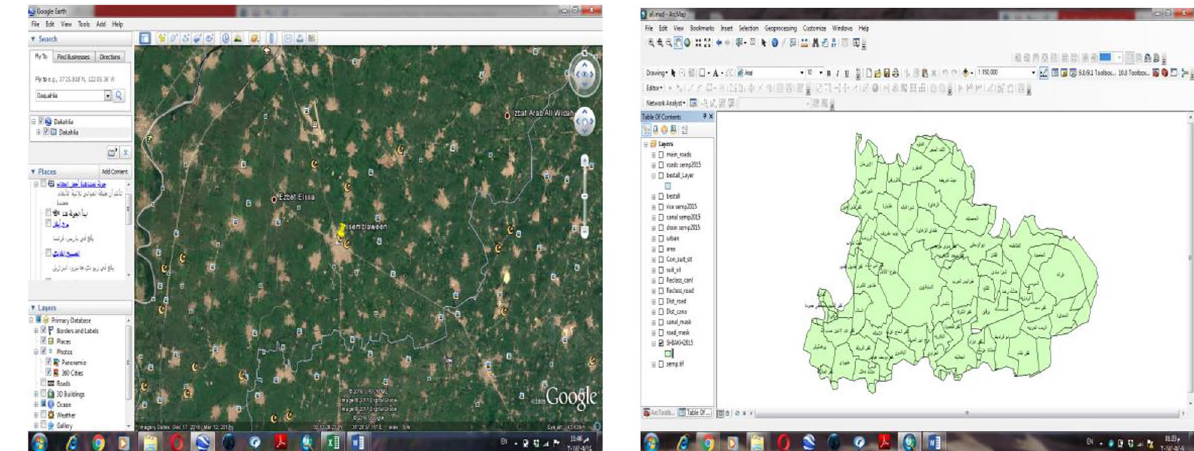
Figure 1. Map of the Sinbilawin city, 2015 (study area).